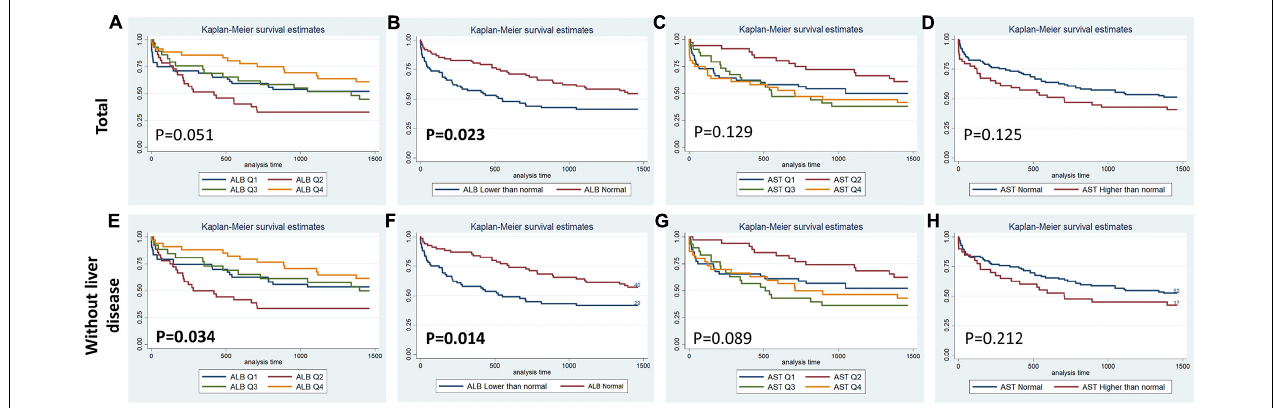
FIGURE 3 | Kaplan–Meier 4-year survival curves comparing patients by liver function index levels. Q, quartile of serum ALB, ALT, AST, and total bilirubin value; Normal, clinical normal value; ALB, blood albumin; ALT, blood alanine transaminase; AST, blood aspartate transaminase. (A–D) Total patients with PPH. (E–H) Patients with PPH and without liver disease.